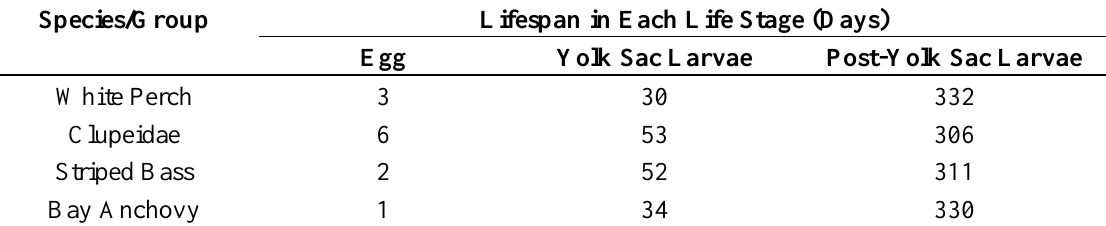
Table 3. IP stage durations.